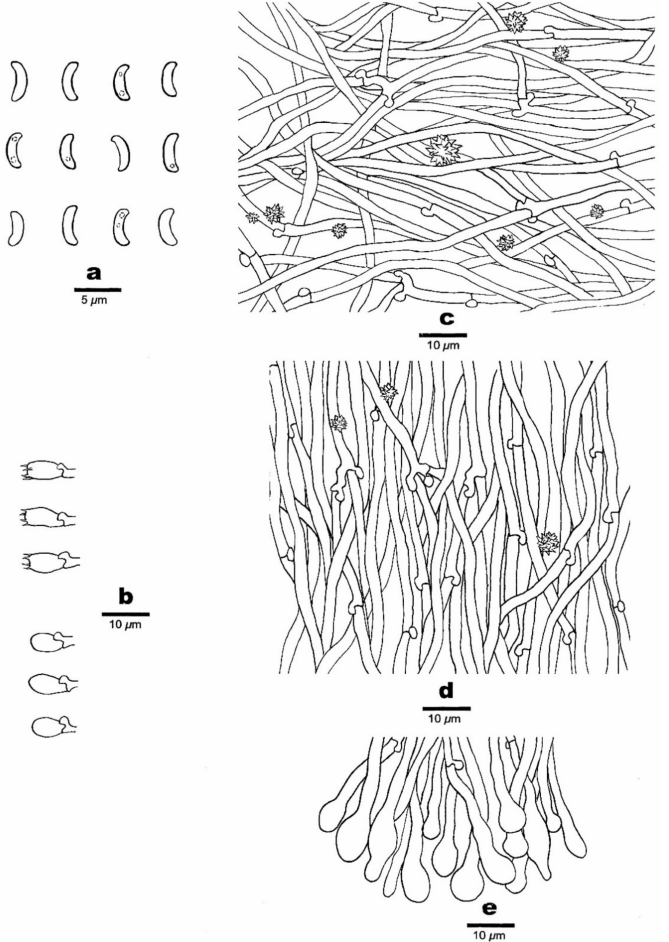
Figure 9. Microscopic structures of Sidera punctata (holotype, Dai 22119). ( a ) Basidiospores. ( b ) Basidia and basidioles. ( c ) Hyphae from subiculum. ( d ) Hyphae from trama. ( e ) Hyphae at dissepiment edge. Drawing by Meng